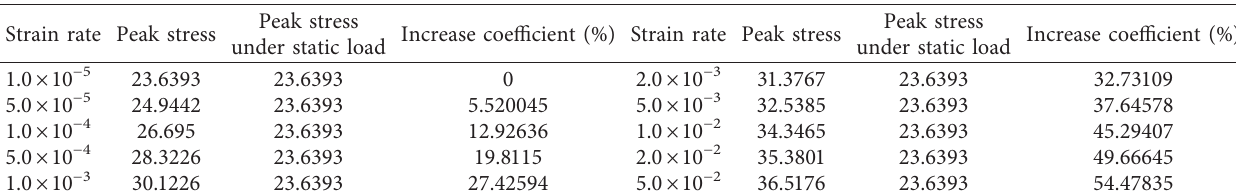
Figure 3: Stress-strain curves of lightweight aggregate concrete for different strain rates. Table 3: The peak stress of lightweight aggregate concrete under various strain rates (MPa).